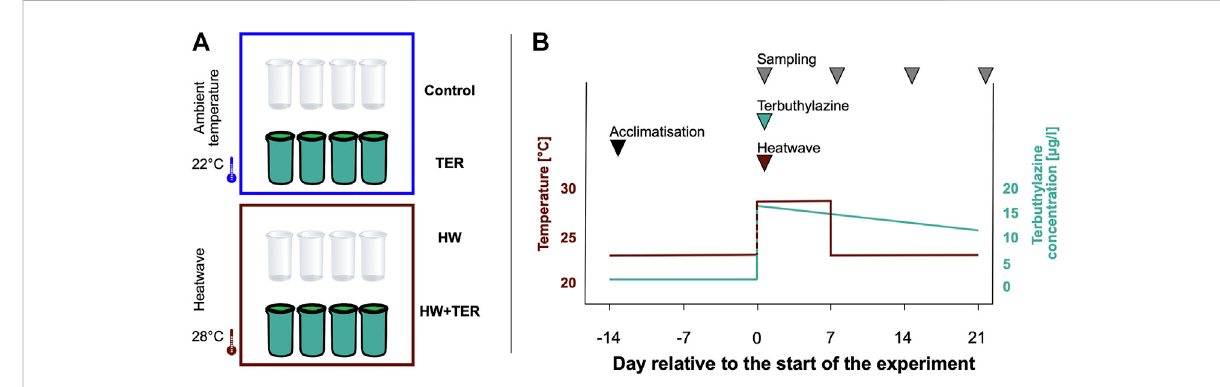
FIGURE 1 (A) Experimentaldesign. (B) Schematictimelineoftheexperiment.Afteranacclimatisationperiodof14 daysat22 ° C,theexperimentwasstarted with the simultaneous application of the heatwave (HW) and the herbicide terbuthylazine (TER) on day 0. The coloured lines represent the temperature(red)andtheterbuthylazine(green)dynamicsinthestressedmicrocosms.Thegreyarrowsmarkthesamplingdays(i.e.,day0,7,14,and 21, relative to the start of the